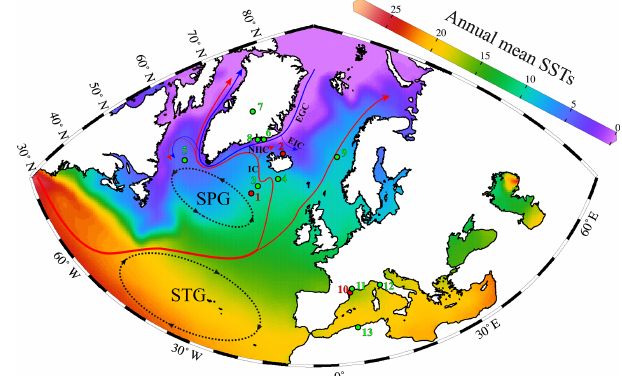
Figure 1. Map of the annual mean SSTs (1955–2012) from the World Ocean Atlas database (https://data.nodc.noaa.gov/las/getUI. do, last access: 1 April 2019; Locarnini et al., 2013) showing the location of the investigated cores and sites used for